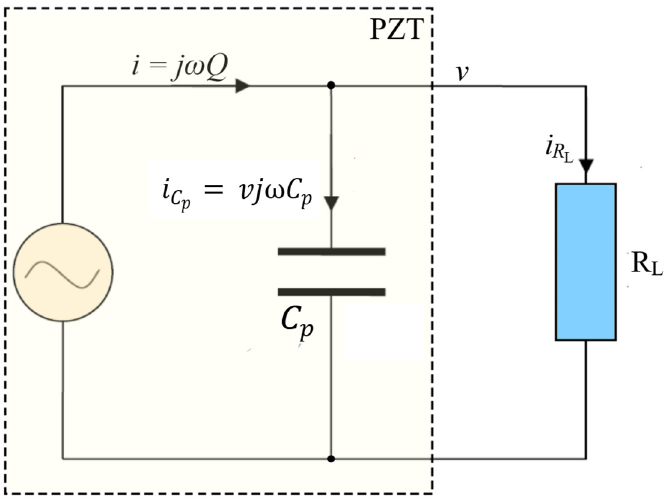
Figure 9. Norton equivalent circuit of a piezoelectric energy harvester.